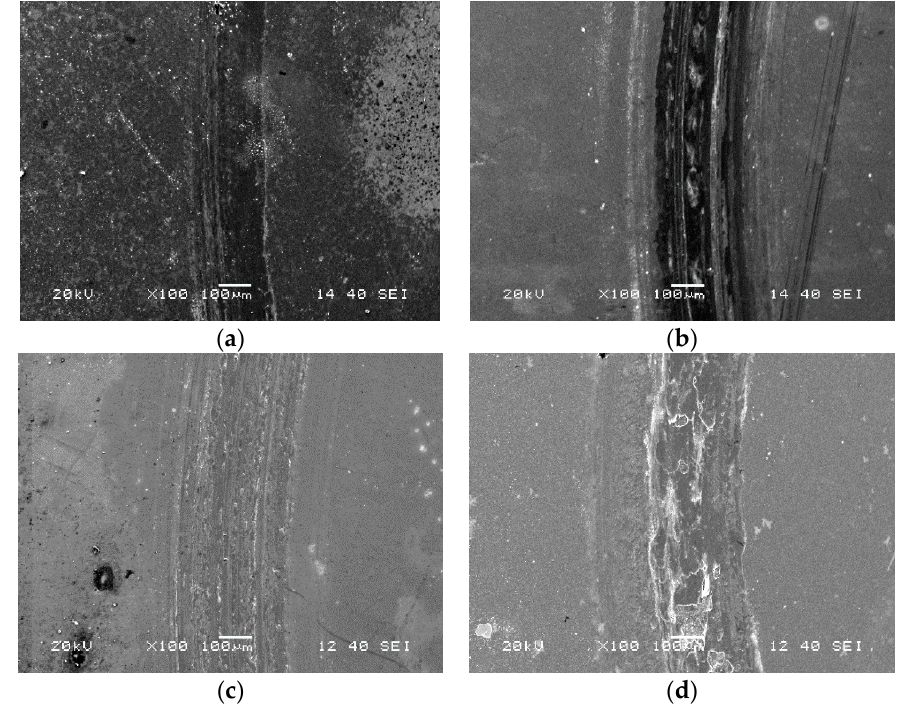
Figure 11. SEM images of the wear tracks of VCN–13.2 at.% Cu and VCN films at different temperatures: ( a ) VCN–Cu, 300 °C; ( b ) VCN–Cu, 500 °C; ( c ) VCN, 300 °C; ( d ) VCN, 500 °C.